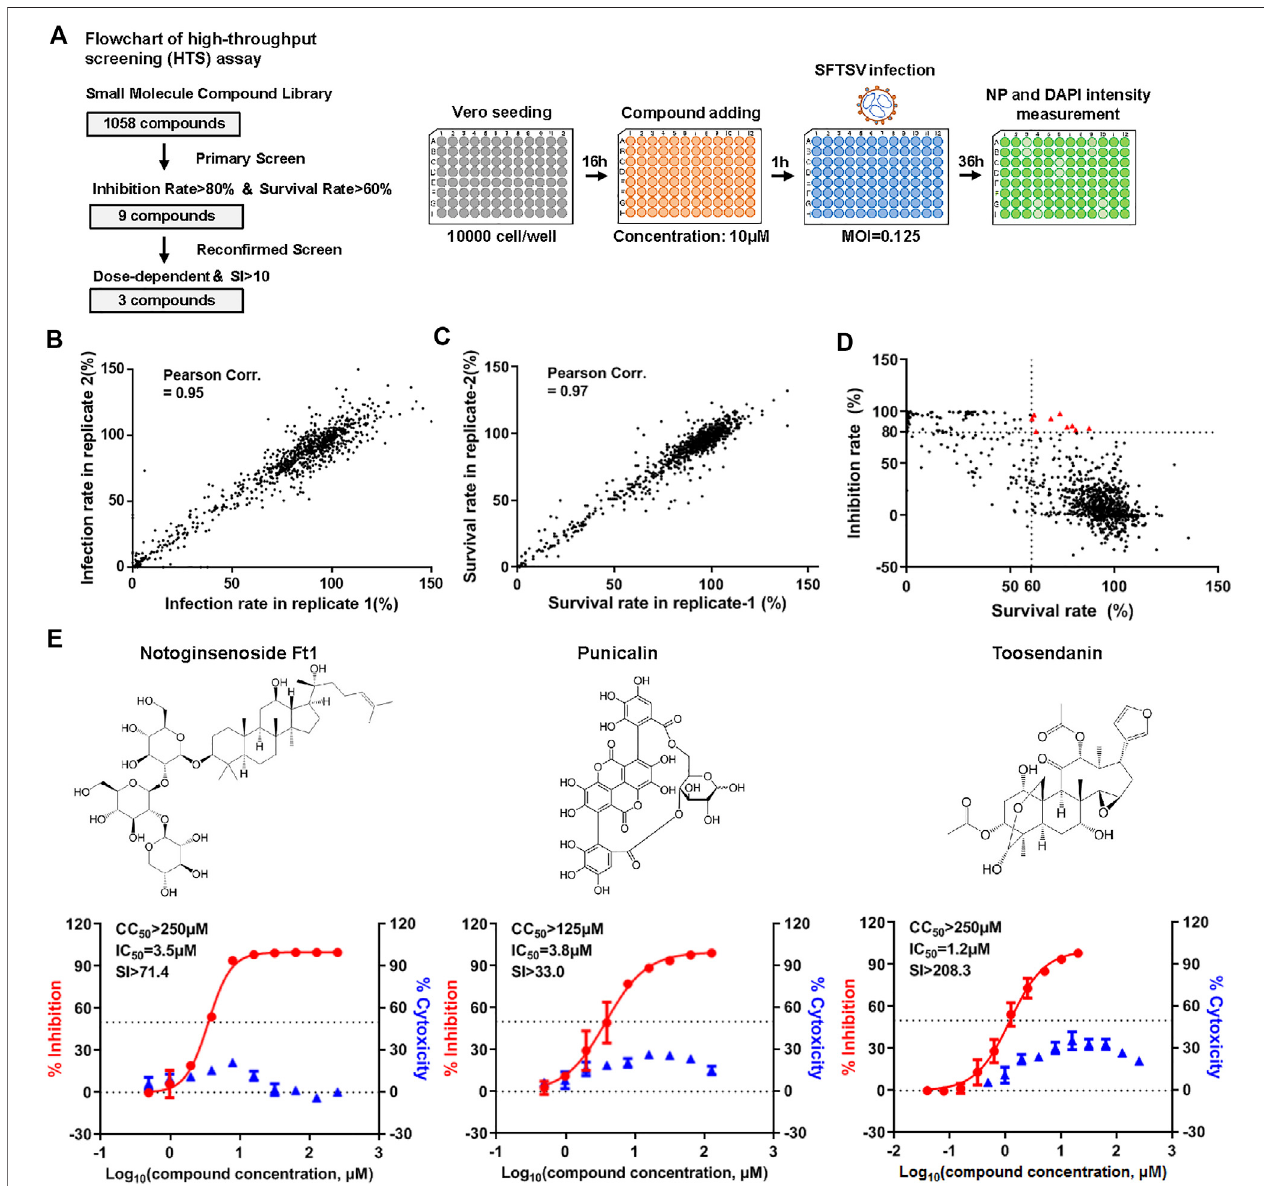
FIGURE1| High-throughput screening(HTS) ofSFTSV inhibitors from anatural extracts library. (A) FlowchartofHTS. (B) Thecorrelationofinfection ratebetween two replicates. (C) The correlation of survival rate between two replicates. (D) Primary screen identi fi ed nine candidates with inhibition rate > 80% and survival rate is > 60% (red triangle). (E) Recon fi rmed screen identi fi ed three compounds with dose-dependent inhibitory effect against SFTSV infection. The left and right Y -axis represent inhibition and cytotoxicity rate of the drugs, respectively.